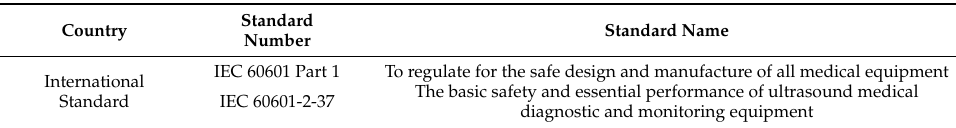
Table 3. International standards related to